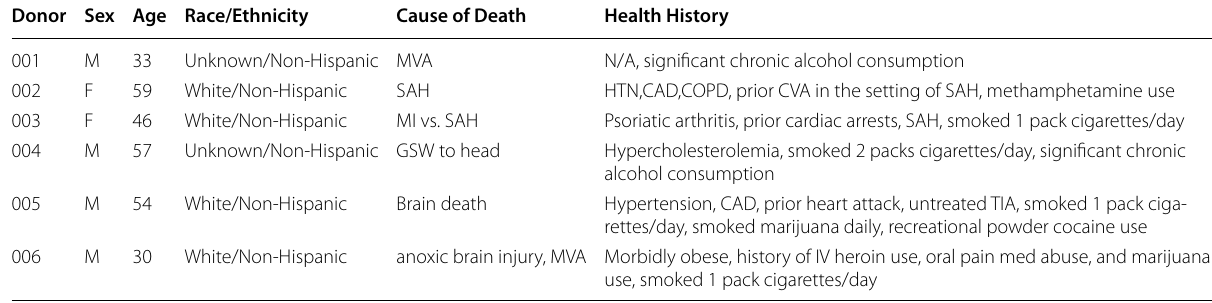
Donor Sex Age Race/Ethnicity Cause of